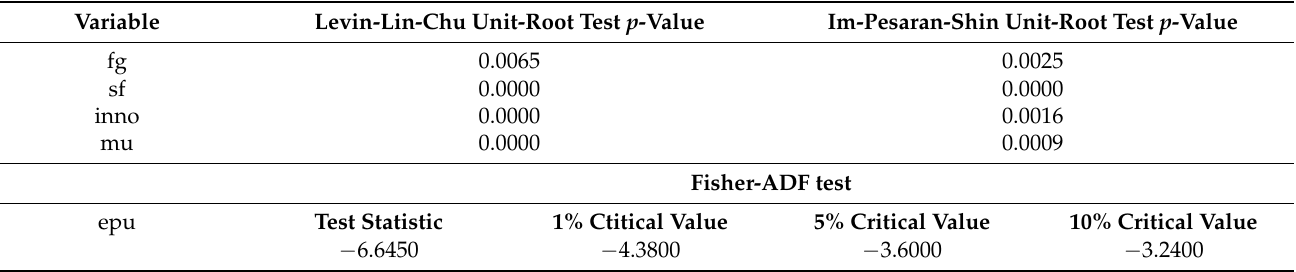
Table 2. Panel VAR unit root results.